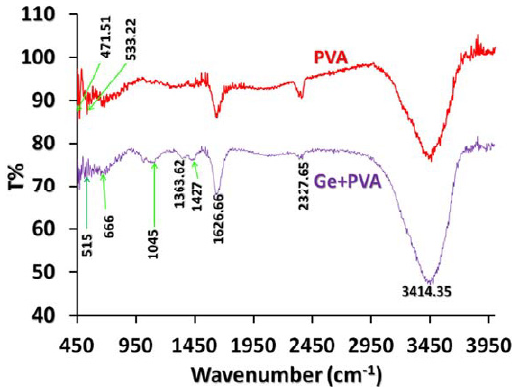
Fig. 2. Fourier transform infrared spectra of PVA and Ge colloidal solutions.